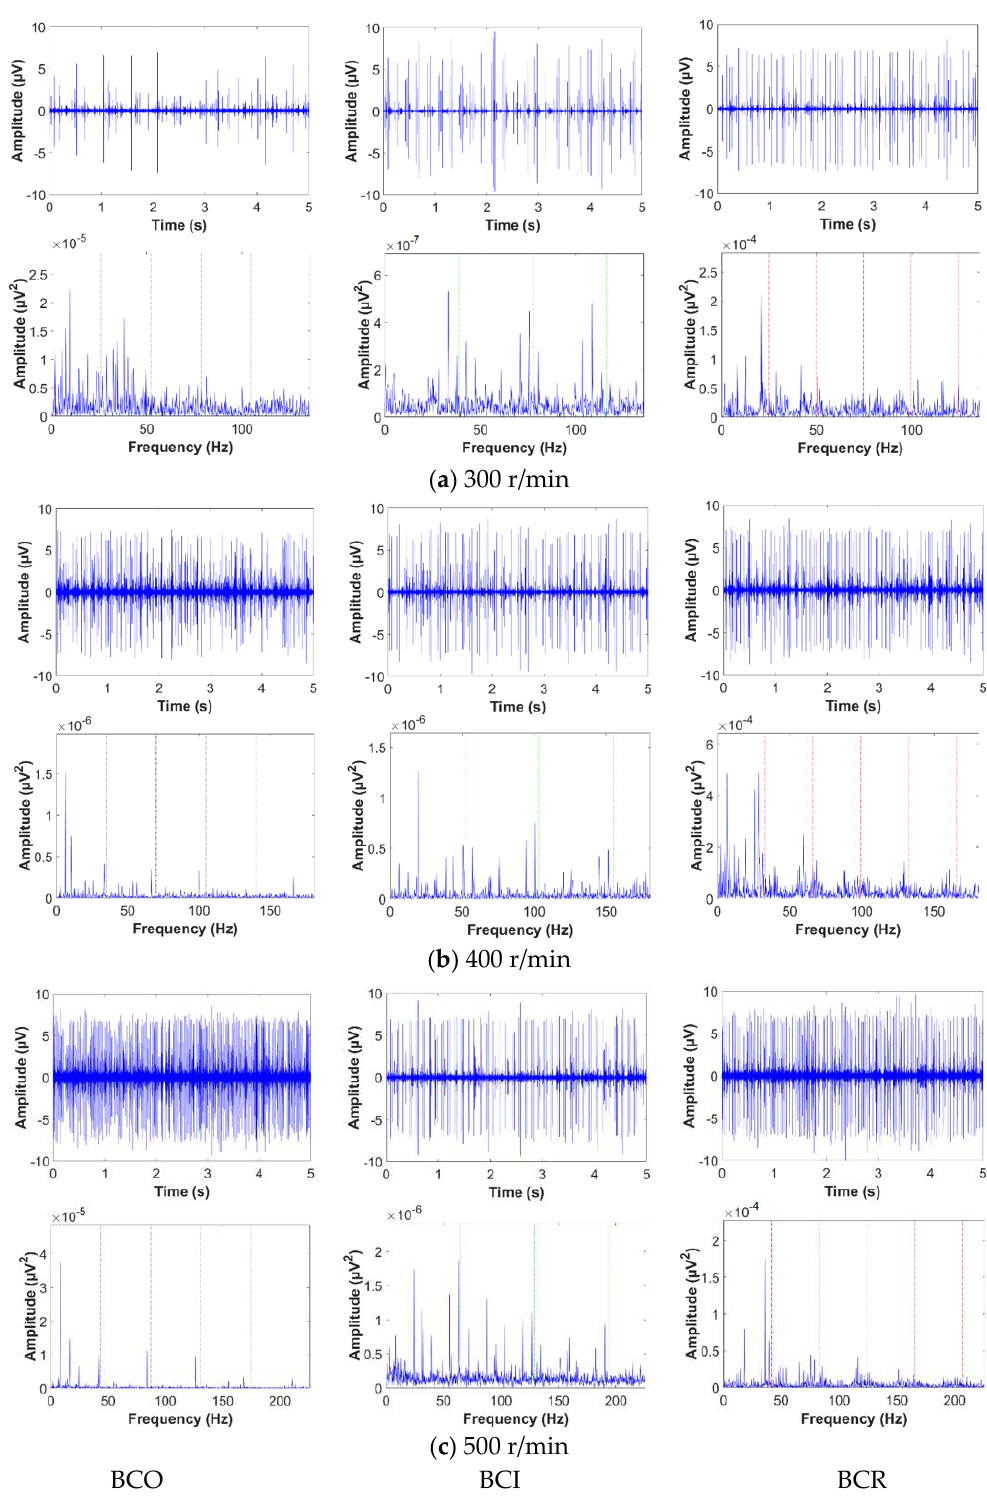
Figure 5. The original acquired AE signals and their initial envelope spectral analysis in frequency domain for bearing conditions related to BCO, BCI, and BCR at the variable rotational speeds: ( a ) 300 r/min, ( b ) 400 r/min, and ( c ) 500 r/min.